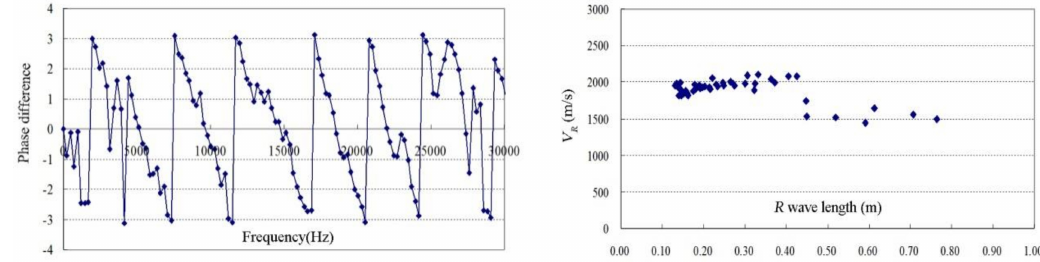
Figure 16. Phase spectrum and dispersion curve at the mid-crown test station at section